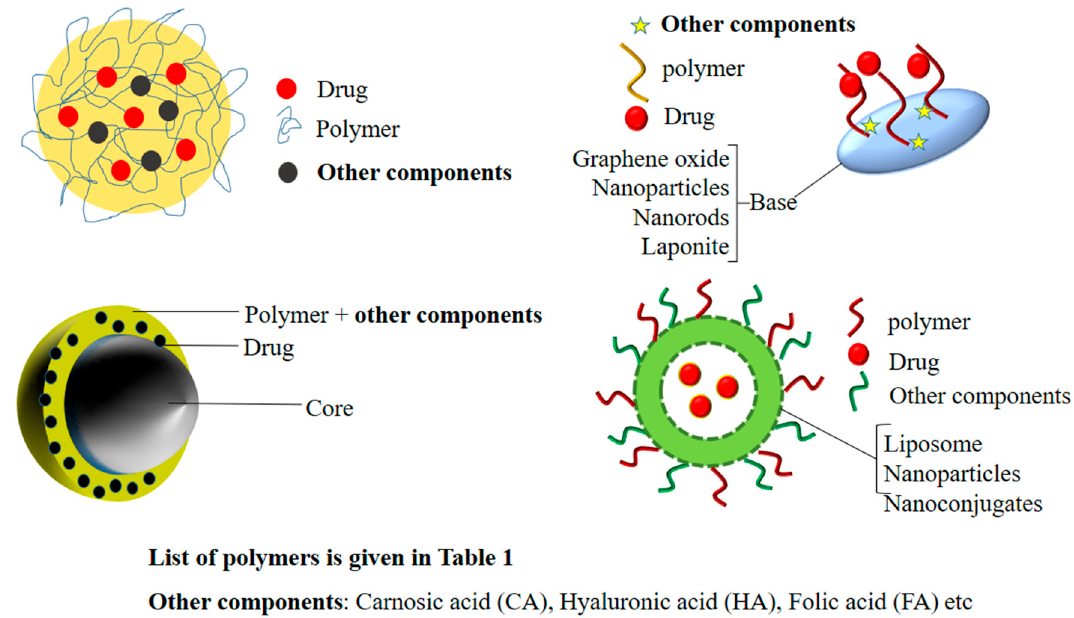
Figure 9 .A generalized structure of other polymer ‐ based nanohybrids. Figure 9. A generalized structure of other polymer-based Table 1 .List of polymeric nanohybrids synthesized in recent years and their role.